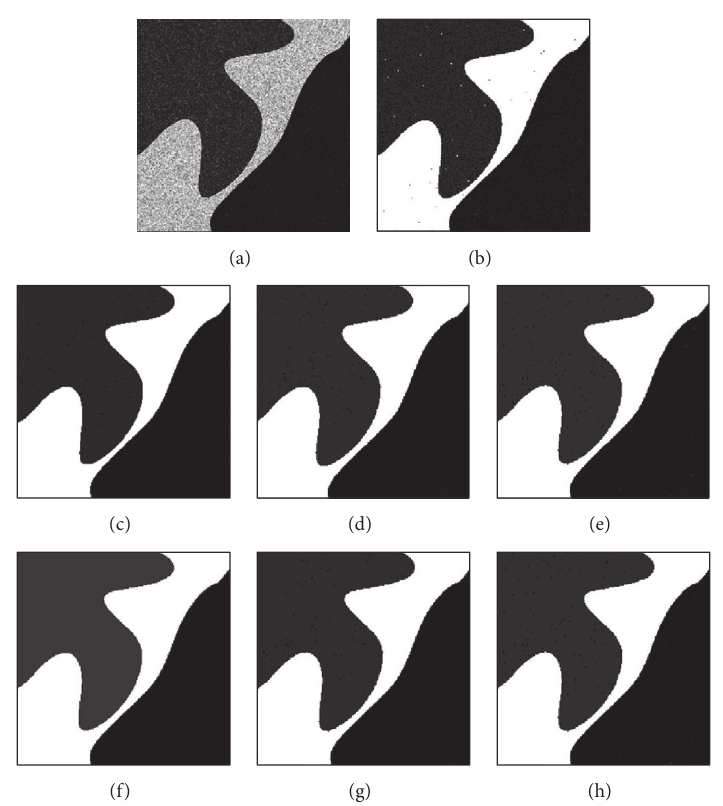
Figure 2: Segmentation results on synthetic image. (a) Original image corrupted by 15% of Gaussian noise. (b) FCM result. (c) FCM S result. (d) FCM S1 result. (e) FCM S2 result. (f) RFCMLGI result. (g) RFCMLGI 1 result. (h) RFCMLGI 2